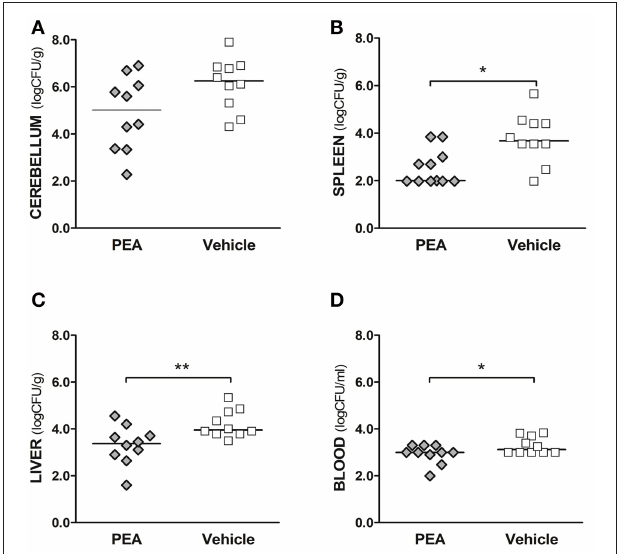
FIGURE 2 | Exogenous PEA reduces bacterial spread in aged mice after the induction of E. coli K1 meningoencephalitis. Concentrations of E. coli K1 were quantified in (A) cerebellum, (B) spleen, and (C) liver (as log 10 CFU/g), as well as in (D) blood (as log 10 CFU/ml) of animals sacrificed 24h after infection with 3,000 CFU E. coli K1/mouse ( n = 10 mice/group, data from two independent experiments). Each symbol represents an individual mouse and bars indicate median values. ** P < 0.01, * P < 0.05 between PEA and vehicle groups, using the Mann–Whitney U -test.